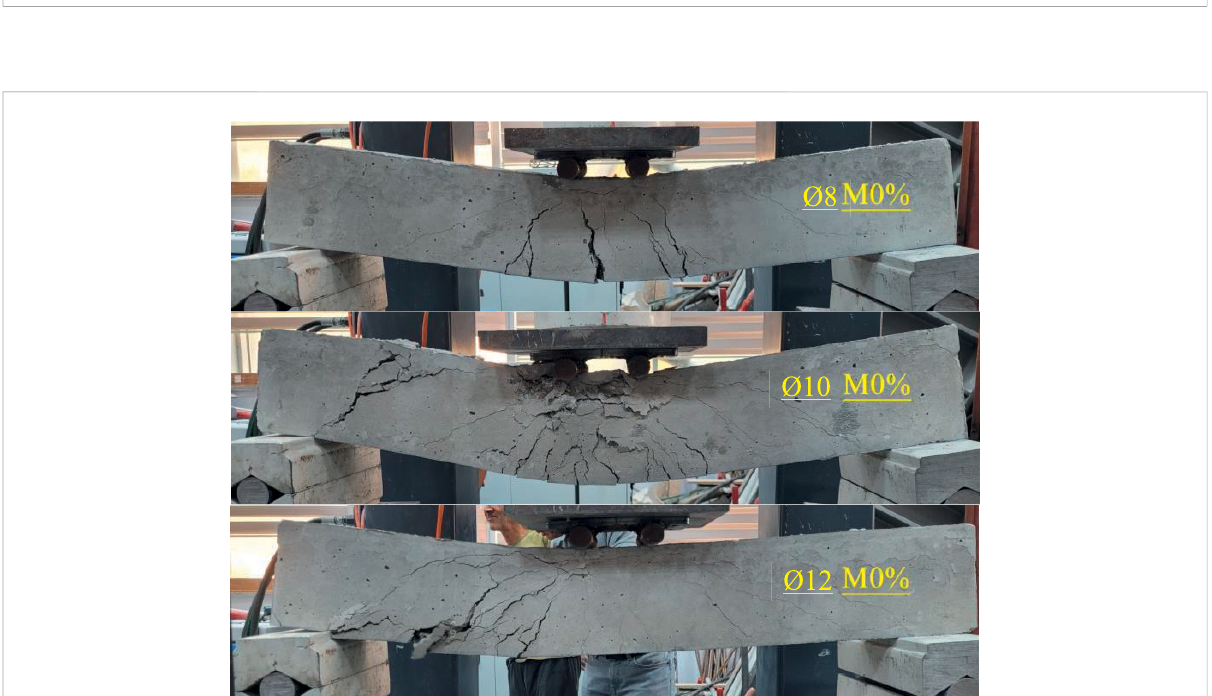
Figure 6. This crushing is signi fi cant because of the impact of the defending behavior of stirrups and reinforcements on the bending behavior of RCBs. In Figure 6, signi fi cant vertical cracks are found in the middle of the RCB and these cracks are so signi fi cantly vital to estimate the crack behavior of RCBs with different amounts of tension reinforcement. As noticed